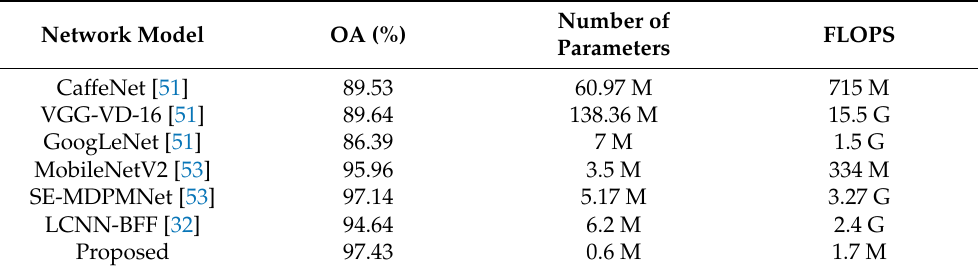
Table 6. Comparison of OA, parameters and FLOPs between the proposed method and some advanced methods on the AID dataset with 50% training ratio.